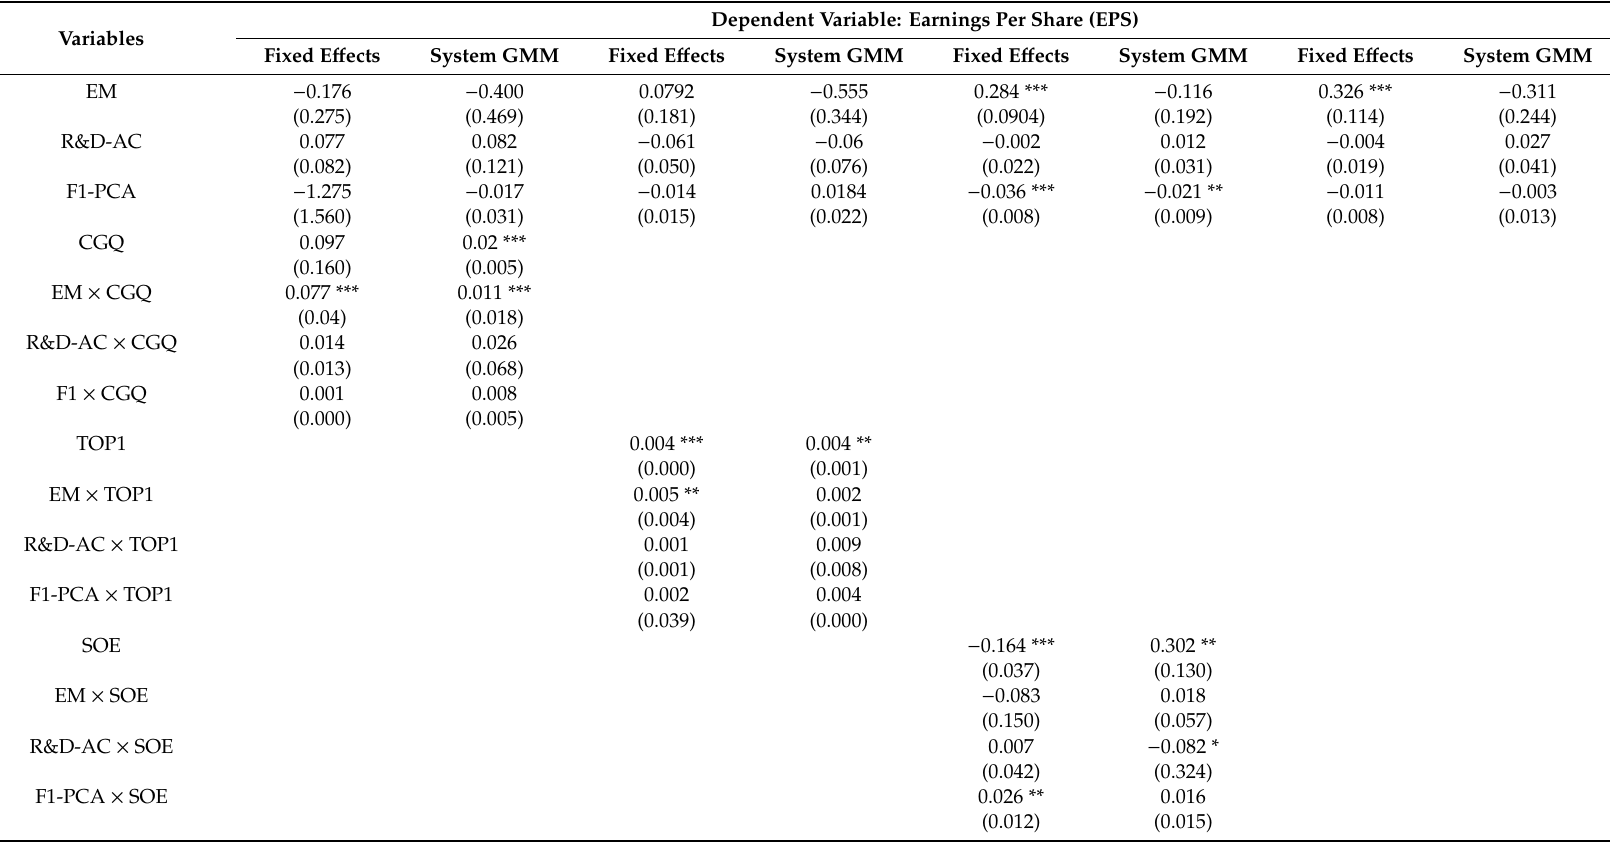
Table 11. Results of baseline models with alternative measure of agency